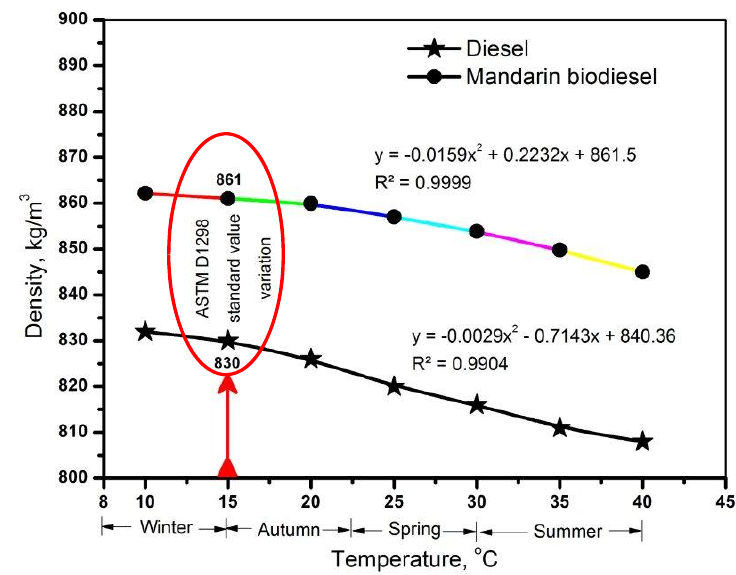
Figure 10. Variation of density with temperature.